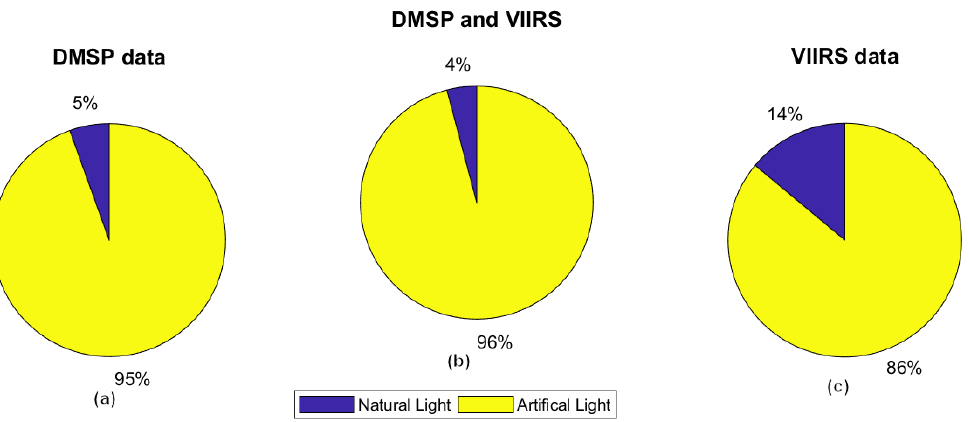
Figure 16. Comparison between the number of references using natural light vs. artificial. ( a ) DMSP data. ( b ) DMSP and VIIRS data. ( c ) VIIRS data.